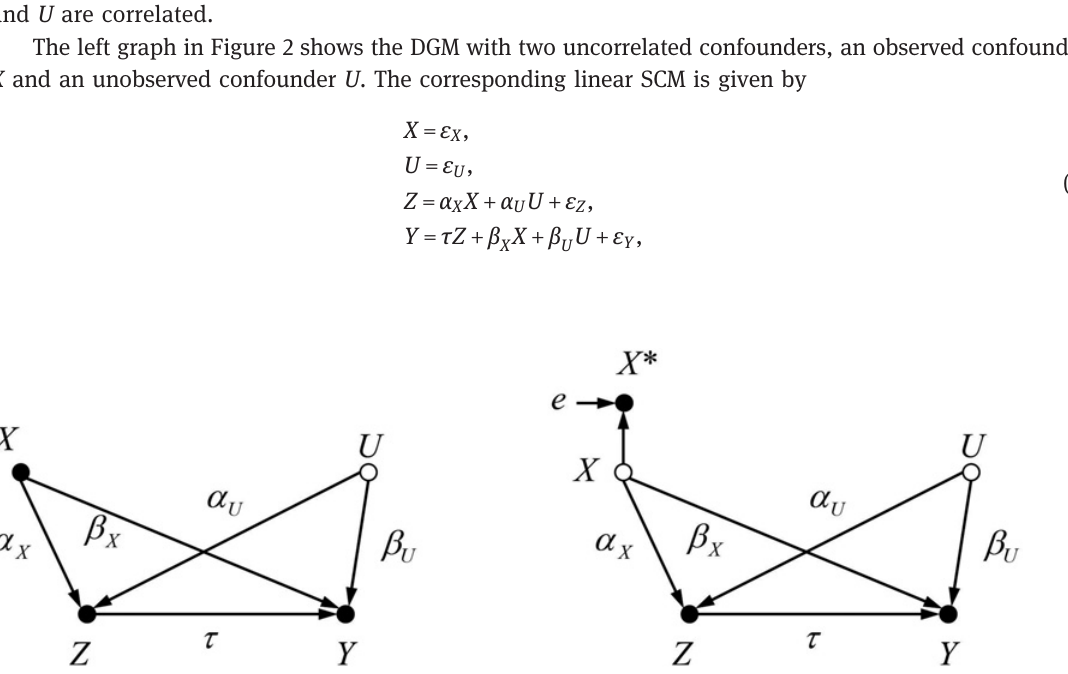
Figure 2: Causal graphs with two uncorrelated confounders X and U , with X reliably measured in the left graph, and X measured with error in the right